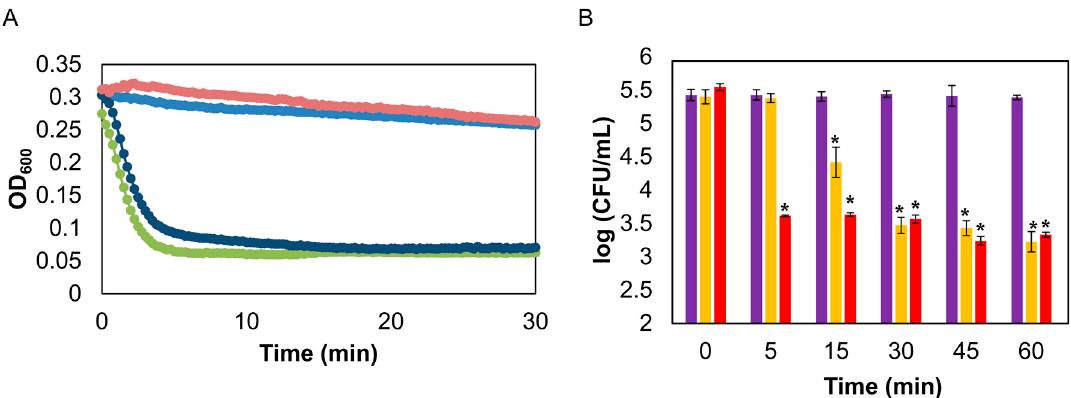
Figure 1. Lytic activity of LysRODI released from pH-sensitive liposomes against S. aureus Sa9 in PBS, pH 5. ( A ) Turbidity reduction assay. Light blue: control without treatment; dark blue: supernatant containing non-encapsulated LysRODI; green: LysRODI released from liposomes; pink: released contents of empty liposomes. ( B ) Time-kill curve. Purple bar: untreated control culture; yellow bar: culture treated with encapsulated LysRODI (previously released); red bar: culture treated with free LysRODI. *, p -value < 0.05.